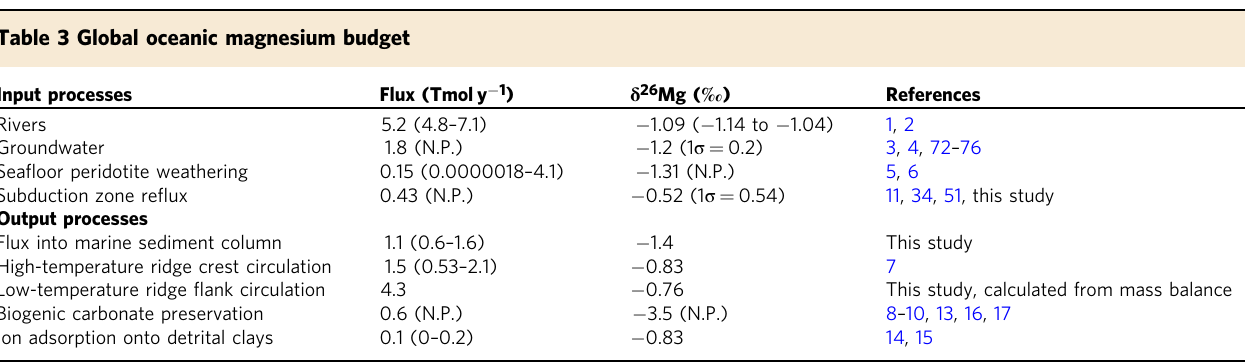
Table 3 Global oceanic magnesium budget Input processes